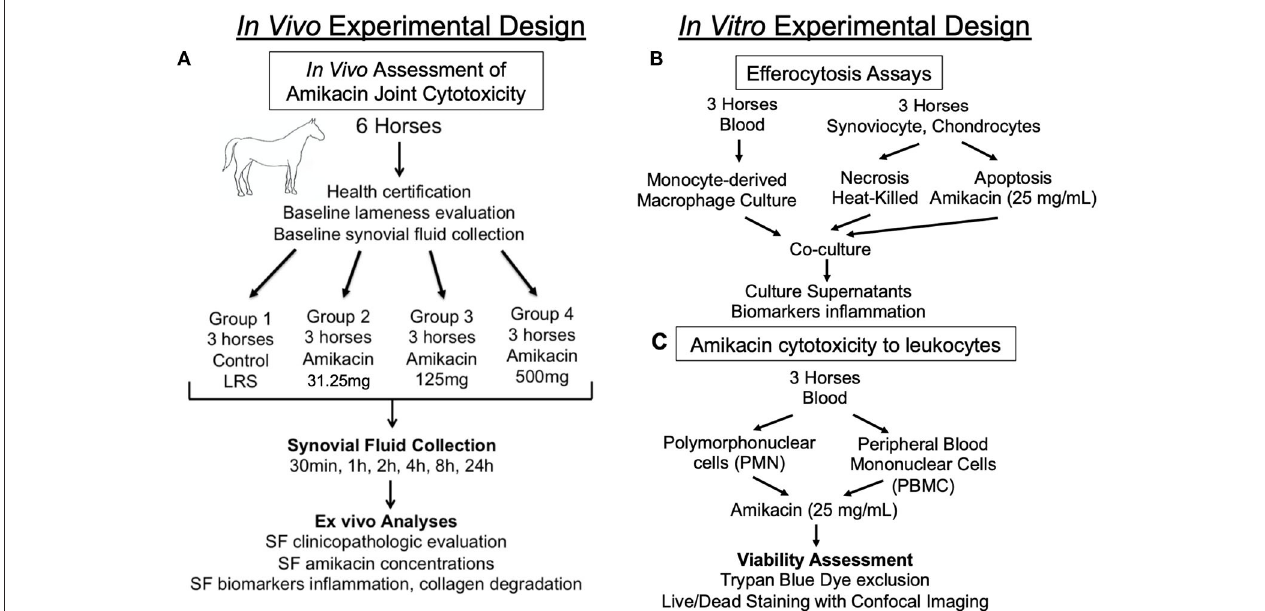
FIGURE 1 | Diagram outlining the experimental design. Schematic overview of the study design for the (A) in vivo assessment of the cytotoxicity of amikacin on the joint of horses; (B) in vitro evaluation of macrophage efferocytosis of joint cells killed by amikacin; and (C) in vitro assessment of amikacin cytotoxicity to leukocytes. SF , synovial